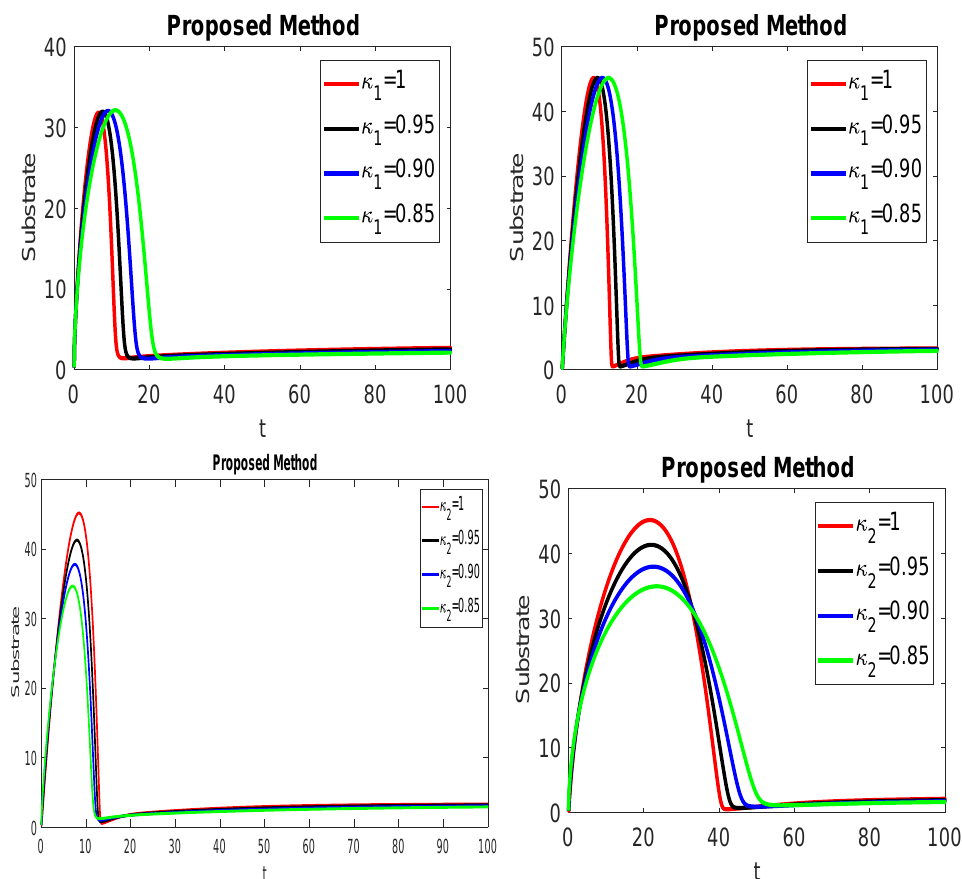
Figure 1. Graphical representation of substrate for different values of κ 1 and κ 2 .